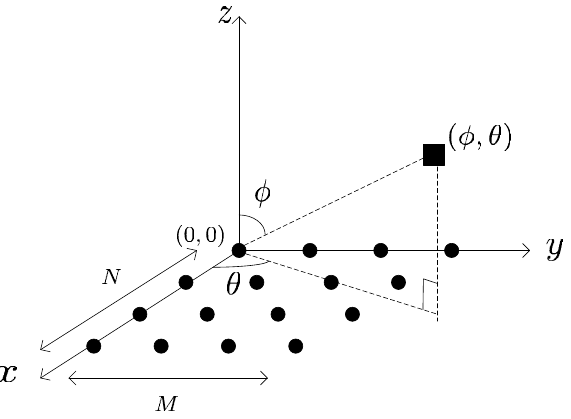
Figure 1. Sensor-source geometry configuration for 2-D direction-of-arrival (DOA)